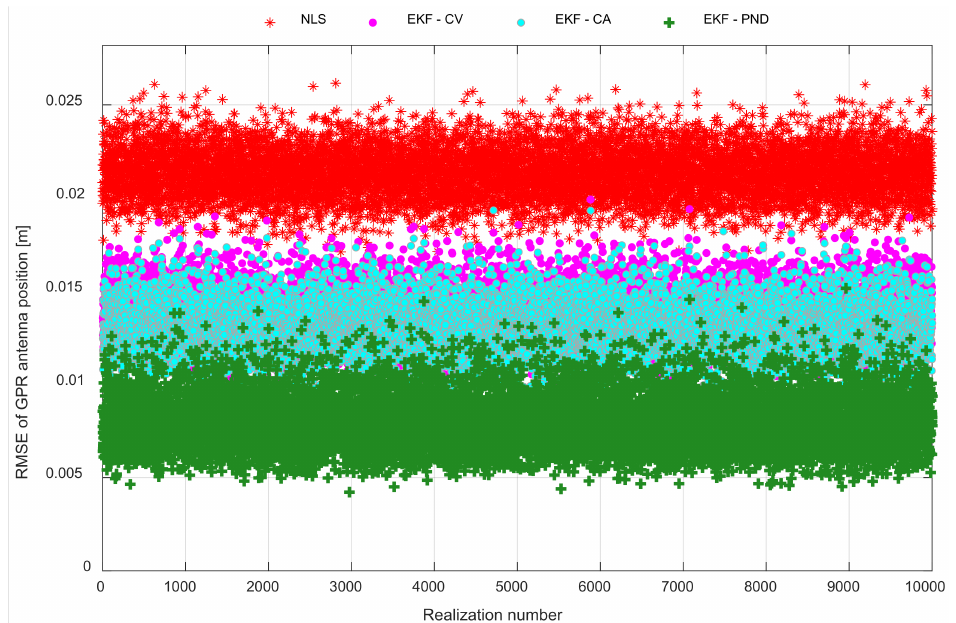
Figure 16. Comparison of RMS antenna position errors for NLS, EKF-CV, EKF-CA, and